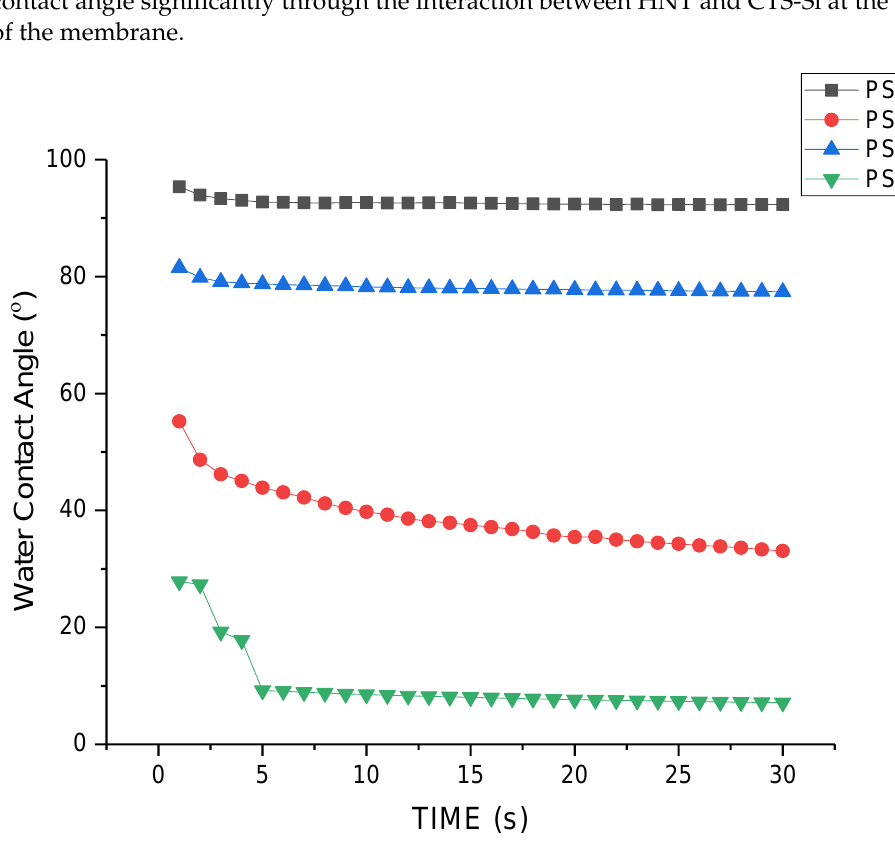
Figure 10. Dynamic contact angle of different types coating onto PSF substrate.